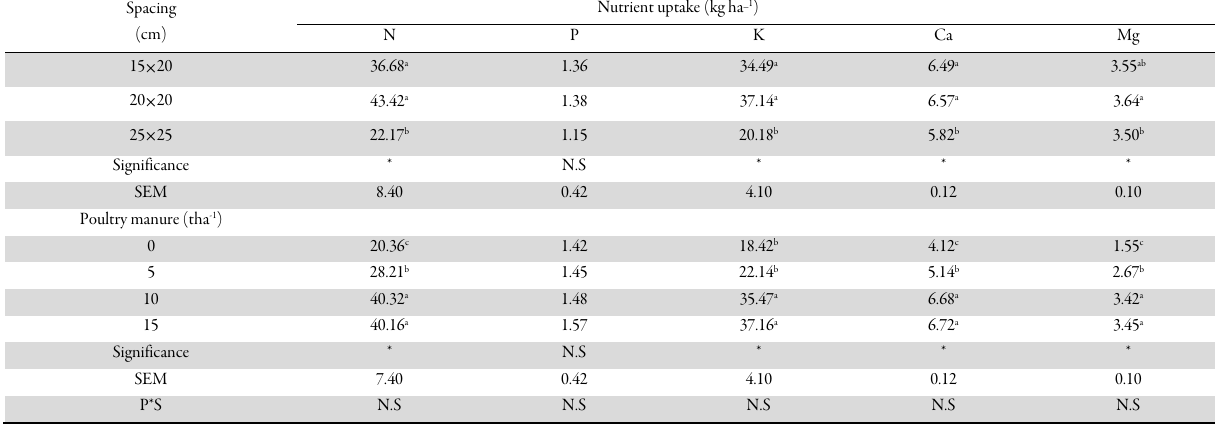
Table 6. Effect of poultry manure and spacing on nutrient uptake of onion leaves Spacing